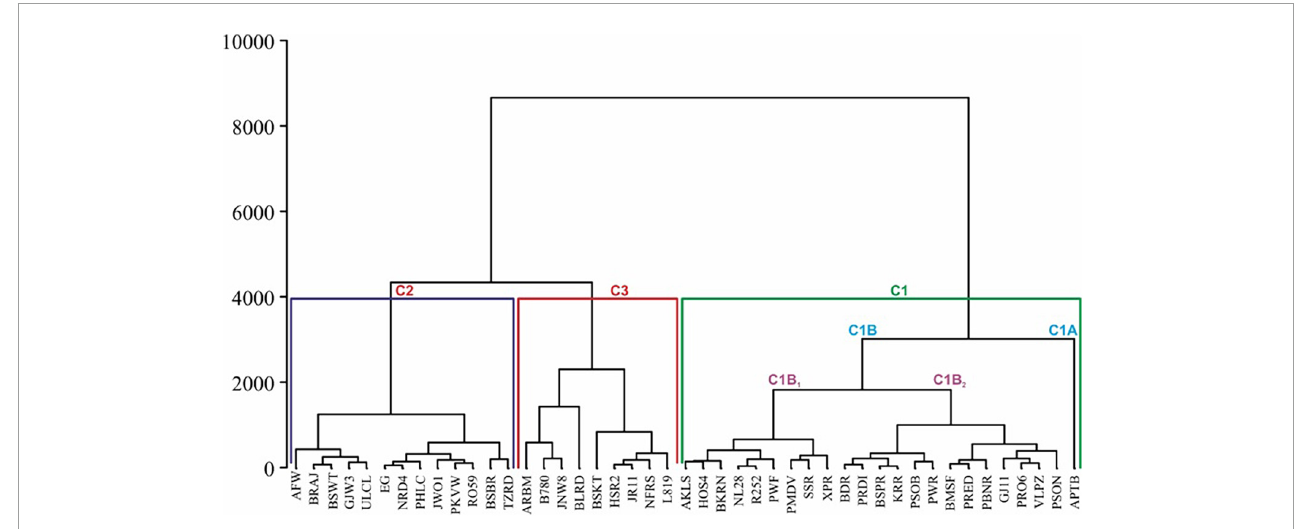
FIGURE4 Hierarchical Clustering of 45 genotypes for K, Na, and P/Na ratio based on the distant neighbour and